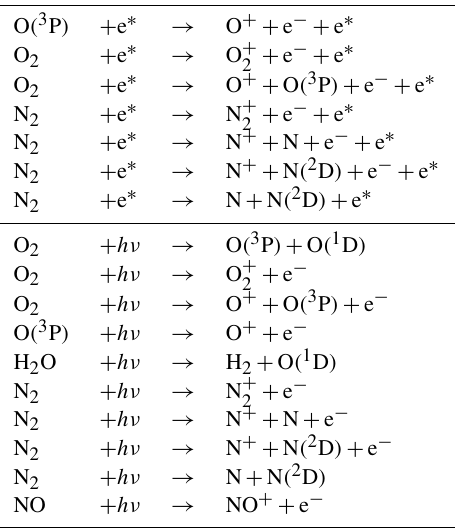
Table 4. New upper atmosphere reactions for which RADJIMT pro- vides j